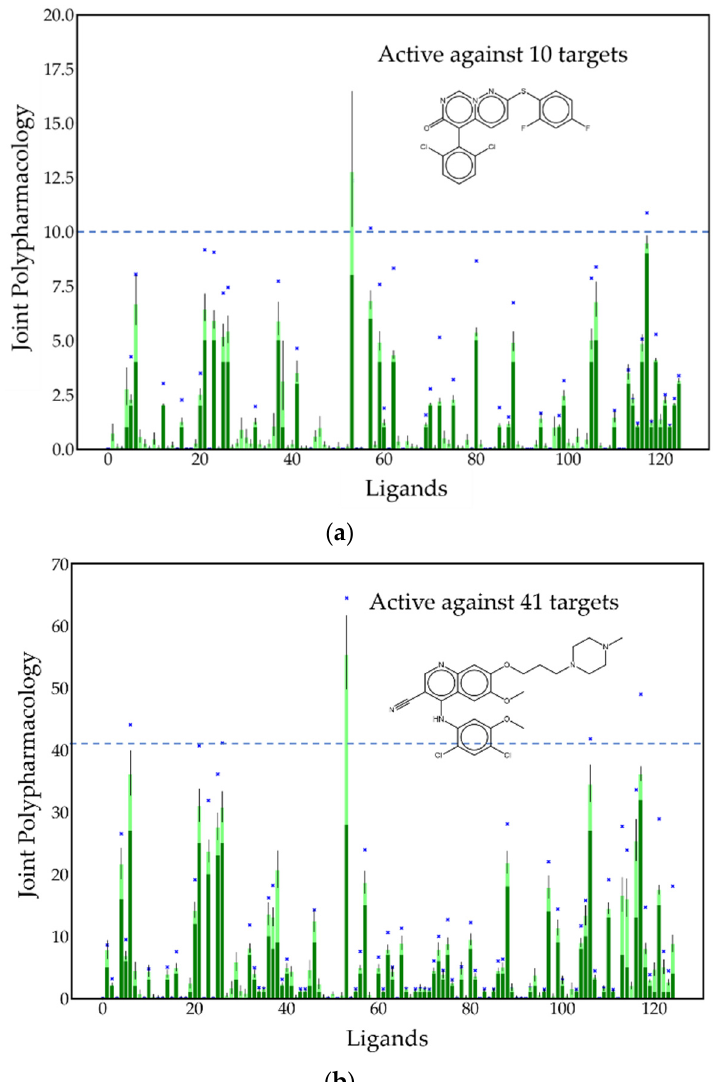
Figure 11. Histogram of estimated joint polypharmacology values for two exemplary ligands. ( a ) CHEMBL119385 and ( b ) CHEMBL288441 taken from the set of 125 ligands of Figure 9 are shown with respect to the other 124 exemplary ligands. The bars represent estimates based on assuming that probabilities are only dependent on the activities of individual ligands, i.e., Pr (cid:3039),(cid:3039) (cid:4594) (∅ (cid:2878) ,∅ (cid:2878) ) = Pr (cid:3039) (∅ (cid:2878) )Pr (∅ (cid:2878) ) . The dark green bars represent the minimum joint polypharmacologies, and the lime green bars represent the contributions from LT pairs where one or both of them are null. The blue x’s show the estimates based on the joint activities of non-null LT pairs according to Equation (63).